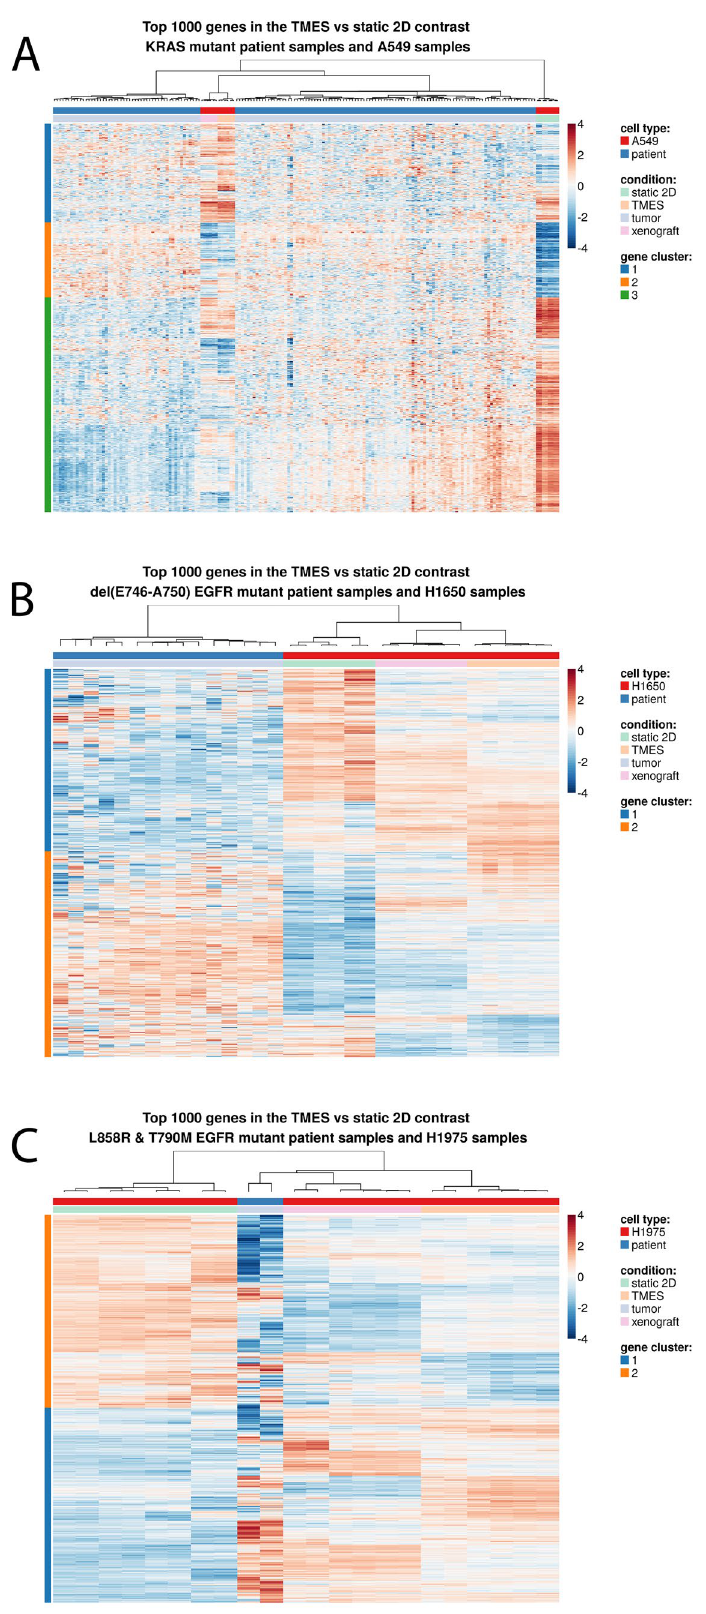
Figure 5. Patient transcriptome similarity to the TMES. Heatmap analysis of the top 1000 genes from the TMES vs 2D static culture contrast of patients in the NSCLC TCGA with the corresponding driver mutation and the three different model systems; TMES, xenograft, and 2D static culture. ( A ) A549, ( B ) H1650, and ( C ) 1975. The heatmap color scales represents row-wise